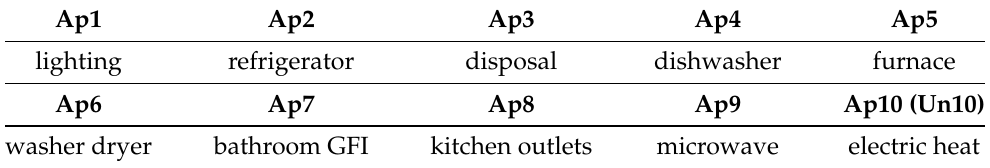
Table 2. The list of appliances in the Reference Energy Disaggregation Data Set (REDD)